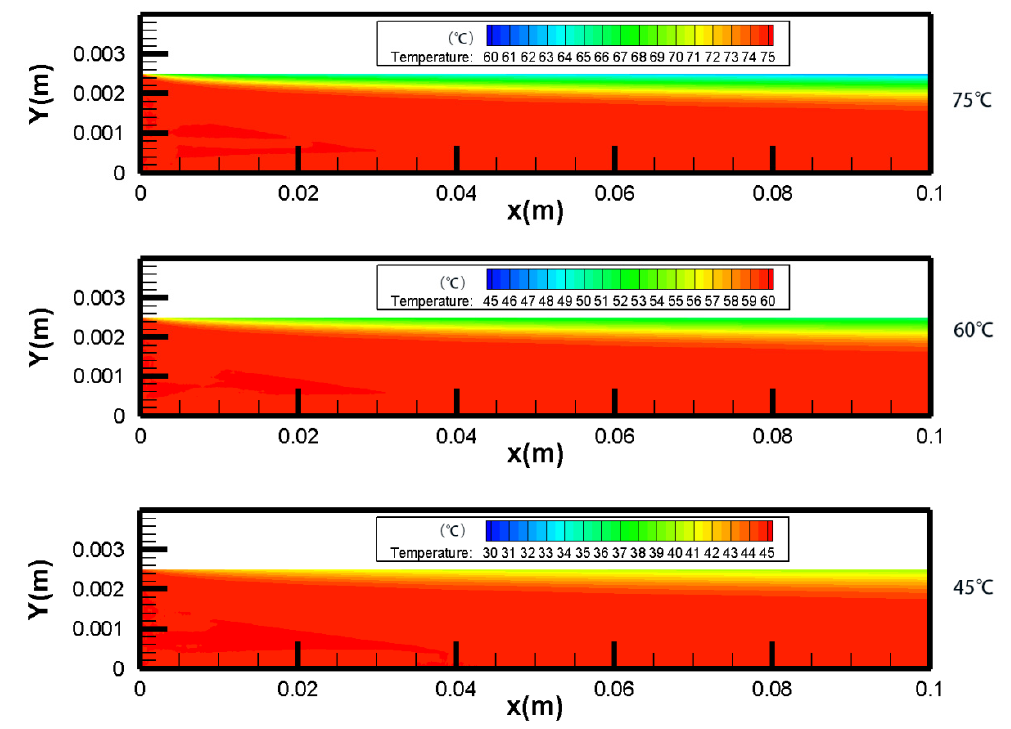
Figure 4. Contours of temperature distribution in different T f ( v f , v p = 0.15m/s, T p = 25 °C, c f = 24.2wt. Figure4. Contoursoftemperaturedistributionindi ff erent T f ( v f , v p = 0.15m / s, T p = 25 ◦ C, c f = %).